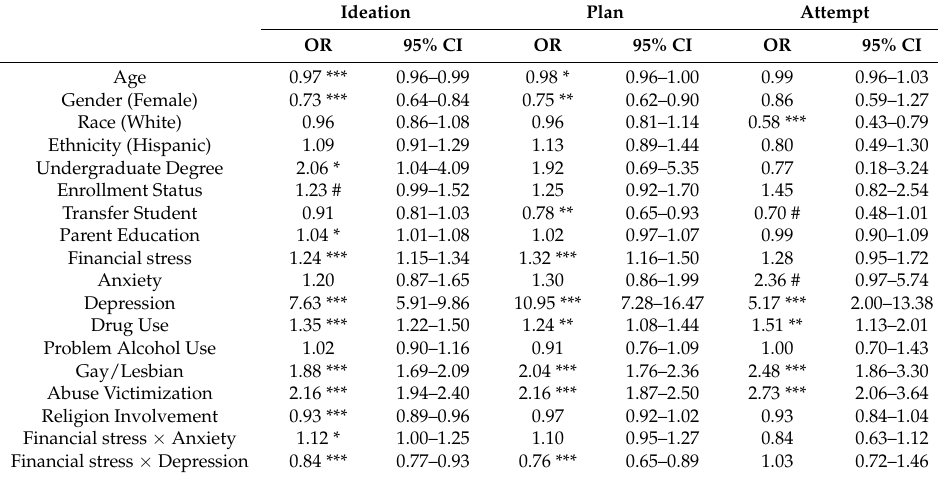
Table 4. Summary of three logistic regressions with suicidal behaviors as